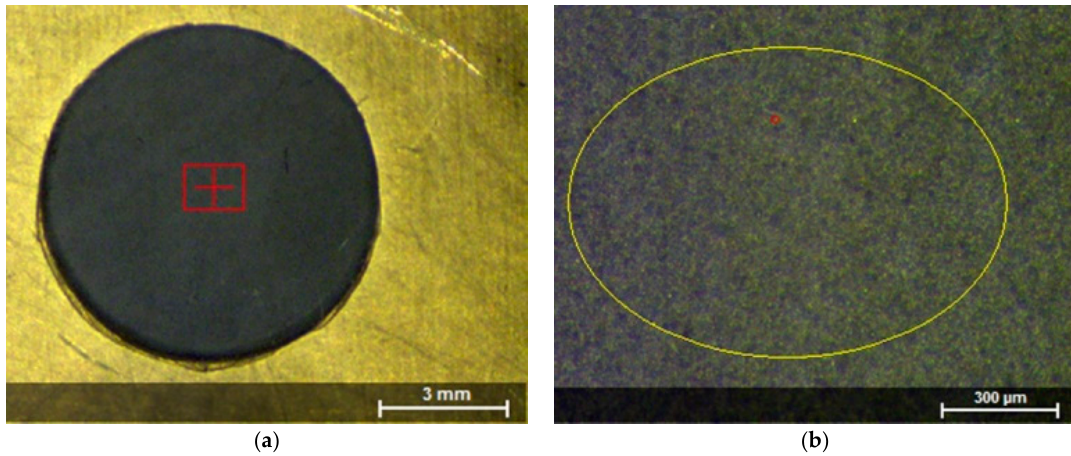
Figure 5. The image of the analyzed region of the surface for the ceramic sample (CCT3) with different magnifications ( × 10 ( a ) and × 100 ( b )).